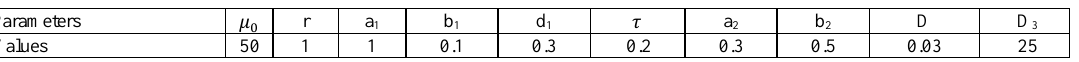
Table 2. Parametric